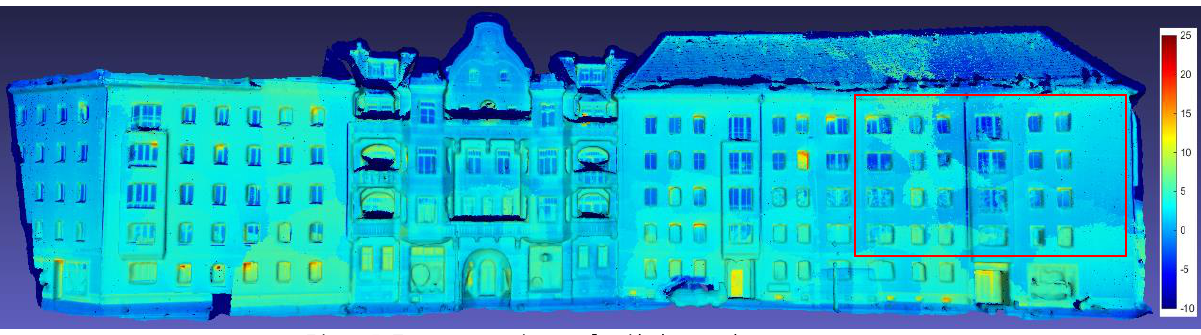
Figure 5. Texture mapping result with the voted textures